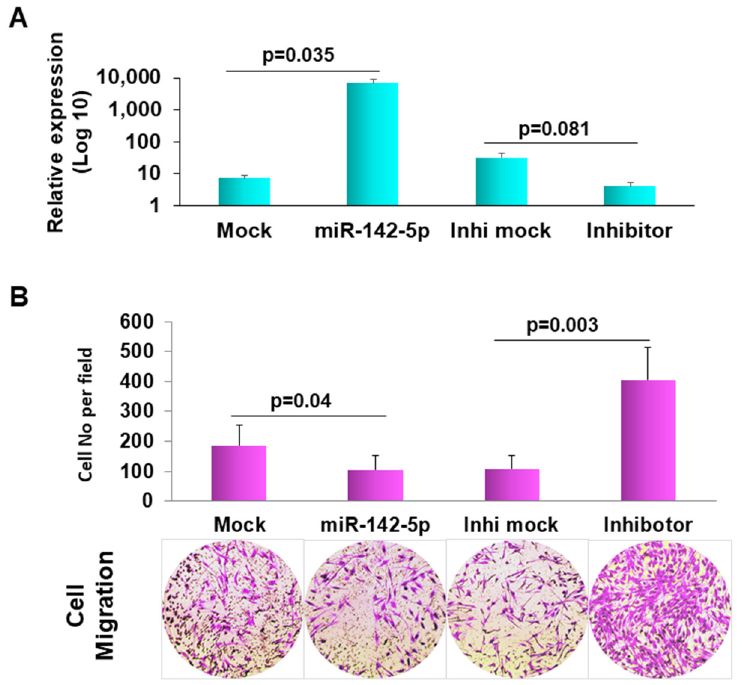
Figure 4. Forced expression of miR-142-5p reduced cell migration. ( A ) Confirmation of transfection of miR-142-5p, inhibitor and the mock controls in normal human dermal fibroblast, PCS-201-010 by qRT-PCR. ( B ) matrigel invasion images (representative ones at the bottom) were pixelized using the Photoshop software version 19.1.3. The migration ability of the cells was displayed as a percentage of the absolute cell numbers. Results are displayed as mean data ± SE ( p < 0.05). Five fields of unit area on each membrane or whole membrane were counted for cell numbers, and the experiments were repeated three times with triplicates.